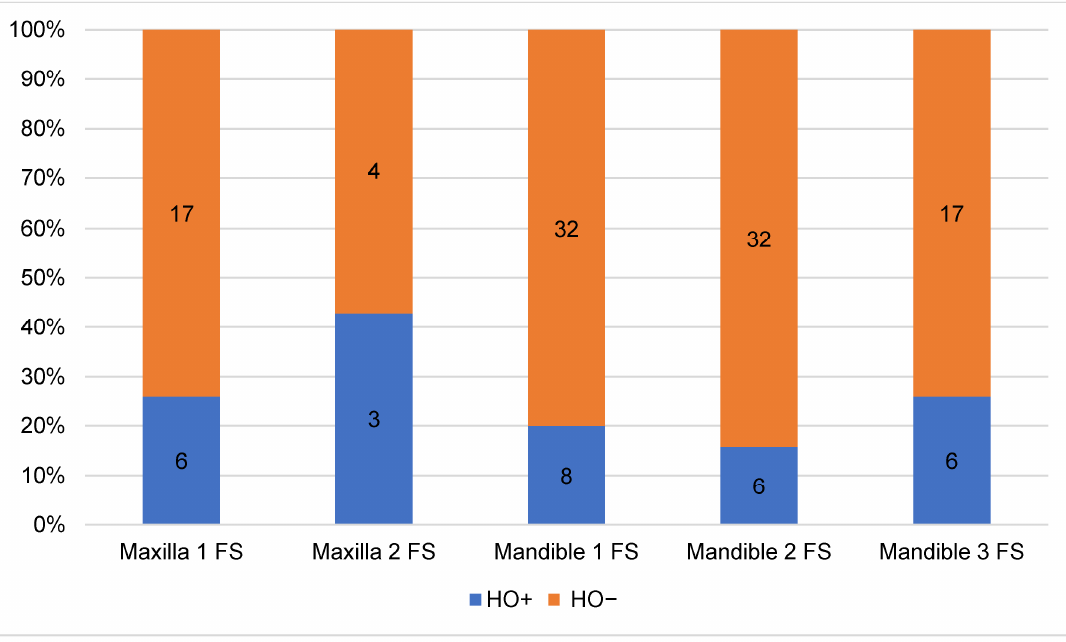
Figure 6. Relative proportion of HO in relation to localization and number of fibula segments (FS) used for jaw reconstruc- tion.